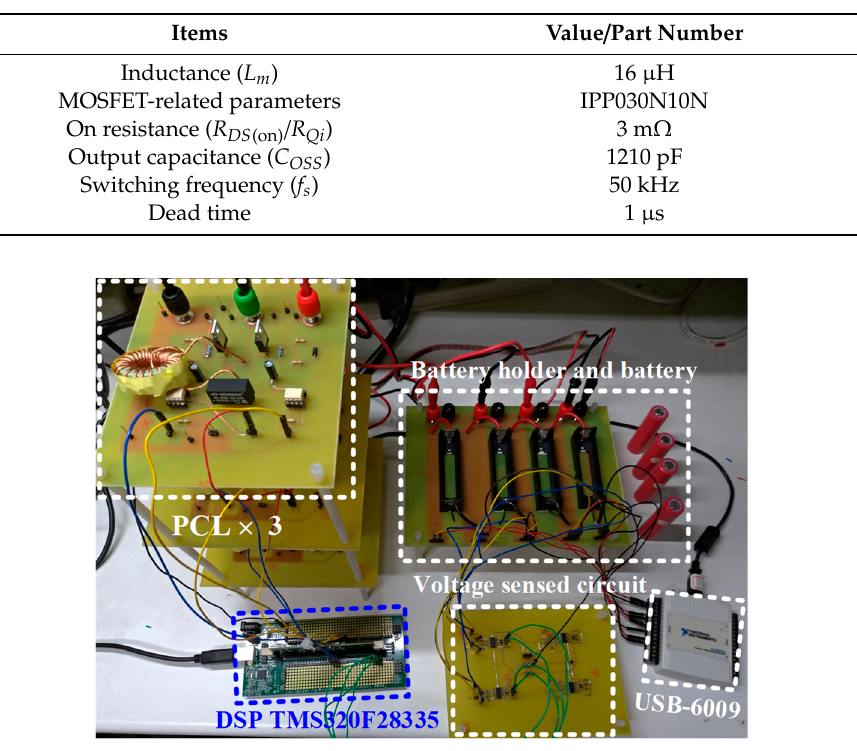
Figure 10. Photograph of the equalizer prototype implemented for a four-cell string.